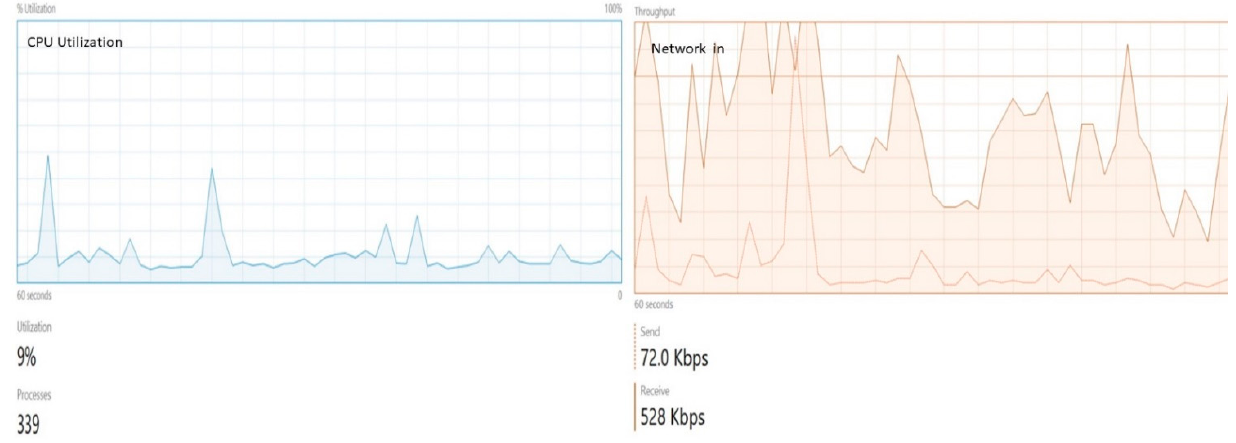
Figure 11. Monitoring network: left side figure shows CPU utilization, and the right side shows network in results .